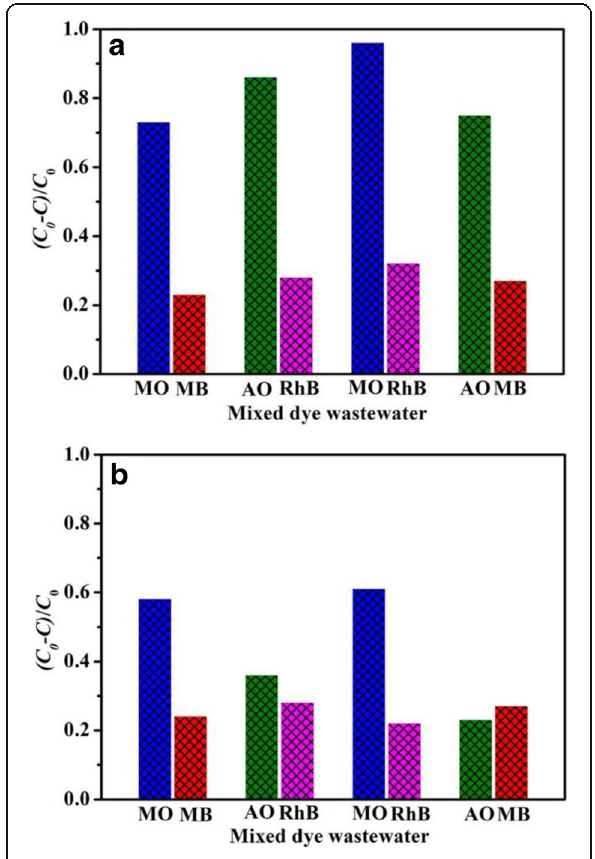
Fig. 10 Adsorption capacities of MO, MB, RhB, and AO in mixed dye solutions on BiOCl ( a ) and Fe/BiOCl ( b ). Adsorption condition 50 mg adsorbent, 25 mL of single dye in mixed dye solution, room temperature. All the concentration of dye solutions is 0.01